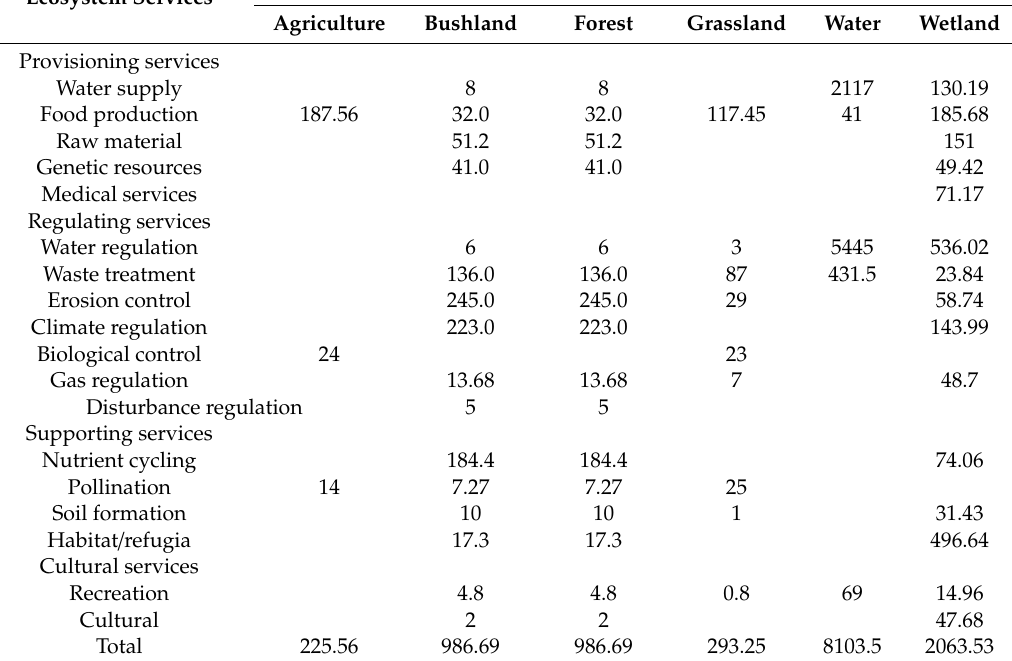
Table 2. Details of the ecosystem service functions and their modified value coe ffi cients for each